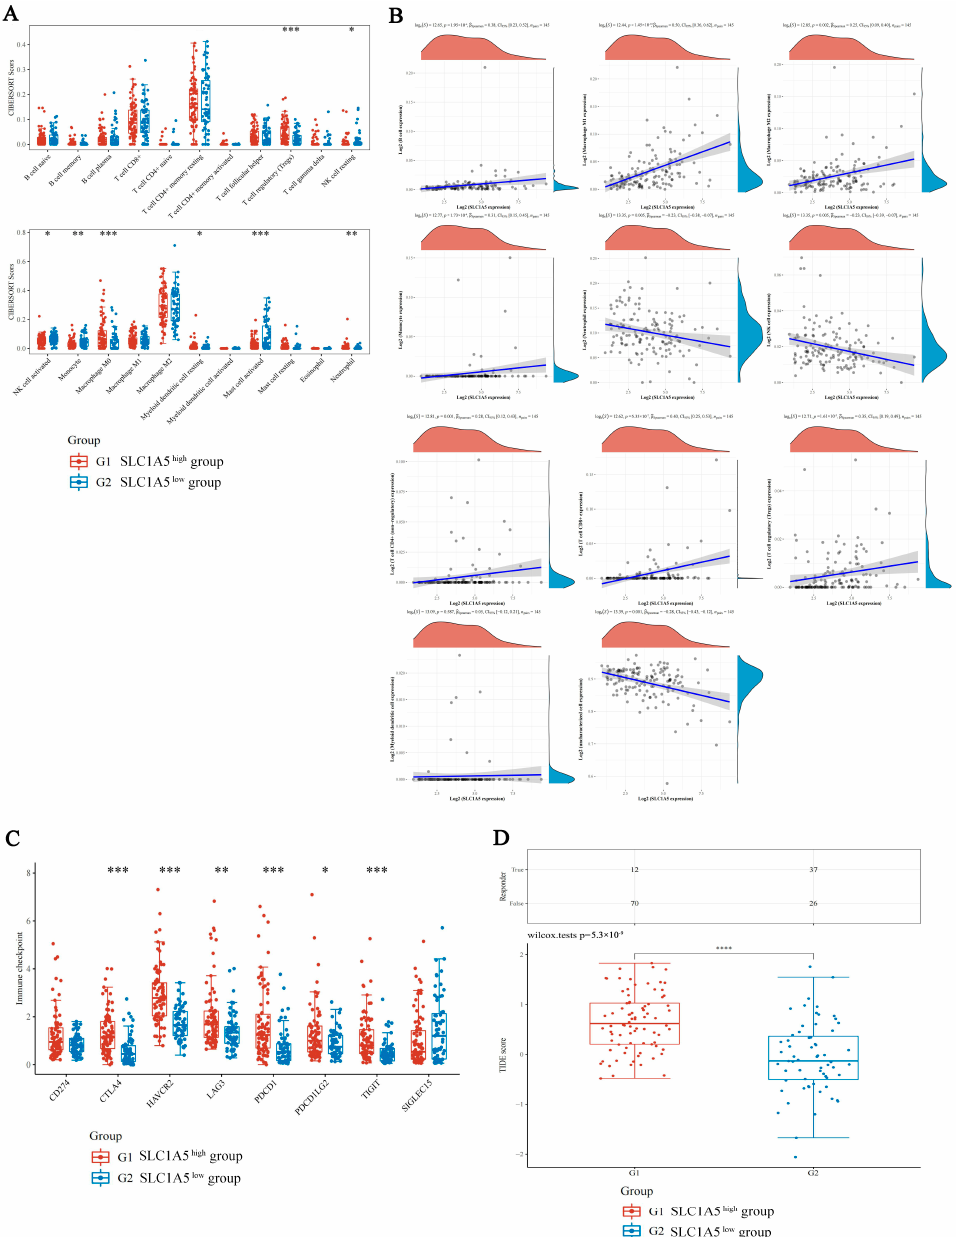
Figure 4. Comparison of immune characteristics and potential ICB response in different expression level groups of SLC1A5 in HBV-related HCC. ( A ) The expression distribution of CIBERSORT immune score in high-SLC1A5 (red) and low-SLC1A5 (blue) groups. The x -axis represents immune cell types, and the y -axis represents the expression distribution of immune score in different groups. ( B ) The correlations between SLC1A5 expression and immune score were analyzed with Spearman. The x -axis represents the distribution of the SLC1A5 expression or the score, and the y -axis represents the distribution of the immune score. The density curve on the right represents the trend in the distribution of the immune score, and the upper density curve represents the trend in the distribution of the gene expression or the score. The value above represents the correlation p value, correlation coefficient and correlation calculation method. ( C ) The expression distribution of immune checkpoints gene in high-SLC1A5 (red) and low-SLC1A5 (blue) groups. The x -axis represents different groups of samples, and the y -axis represents the expression distribution of gene. ( D ) Statistical table of immune response of samples and the distribution of immune response scores in high-SLC1A5 (red) and low-SLC1A5 (blue) groups. * p < 0.05, ** p < 0.01, *** p < 0.001, **** p <